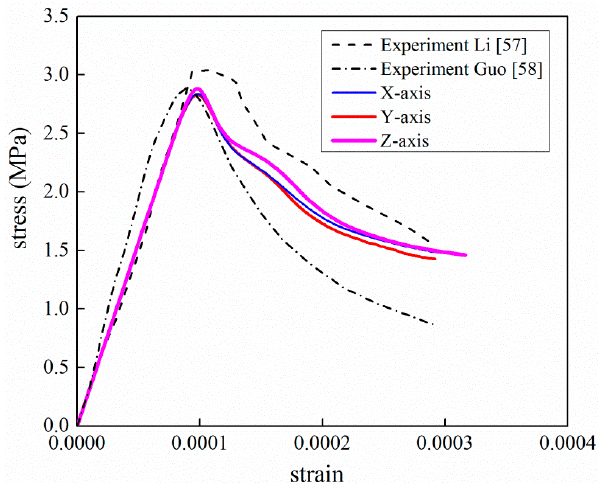
Figure 26. Comparison of stress–strain curves between experiment and simulation under tension (experimental data from